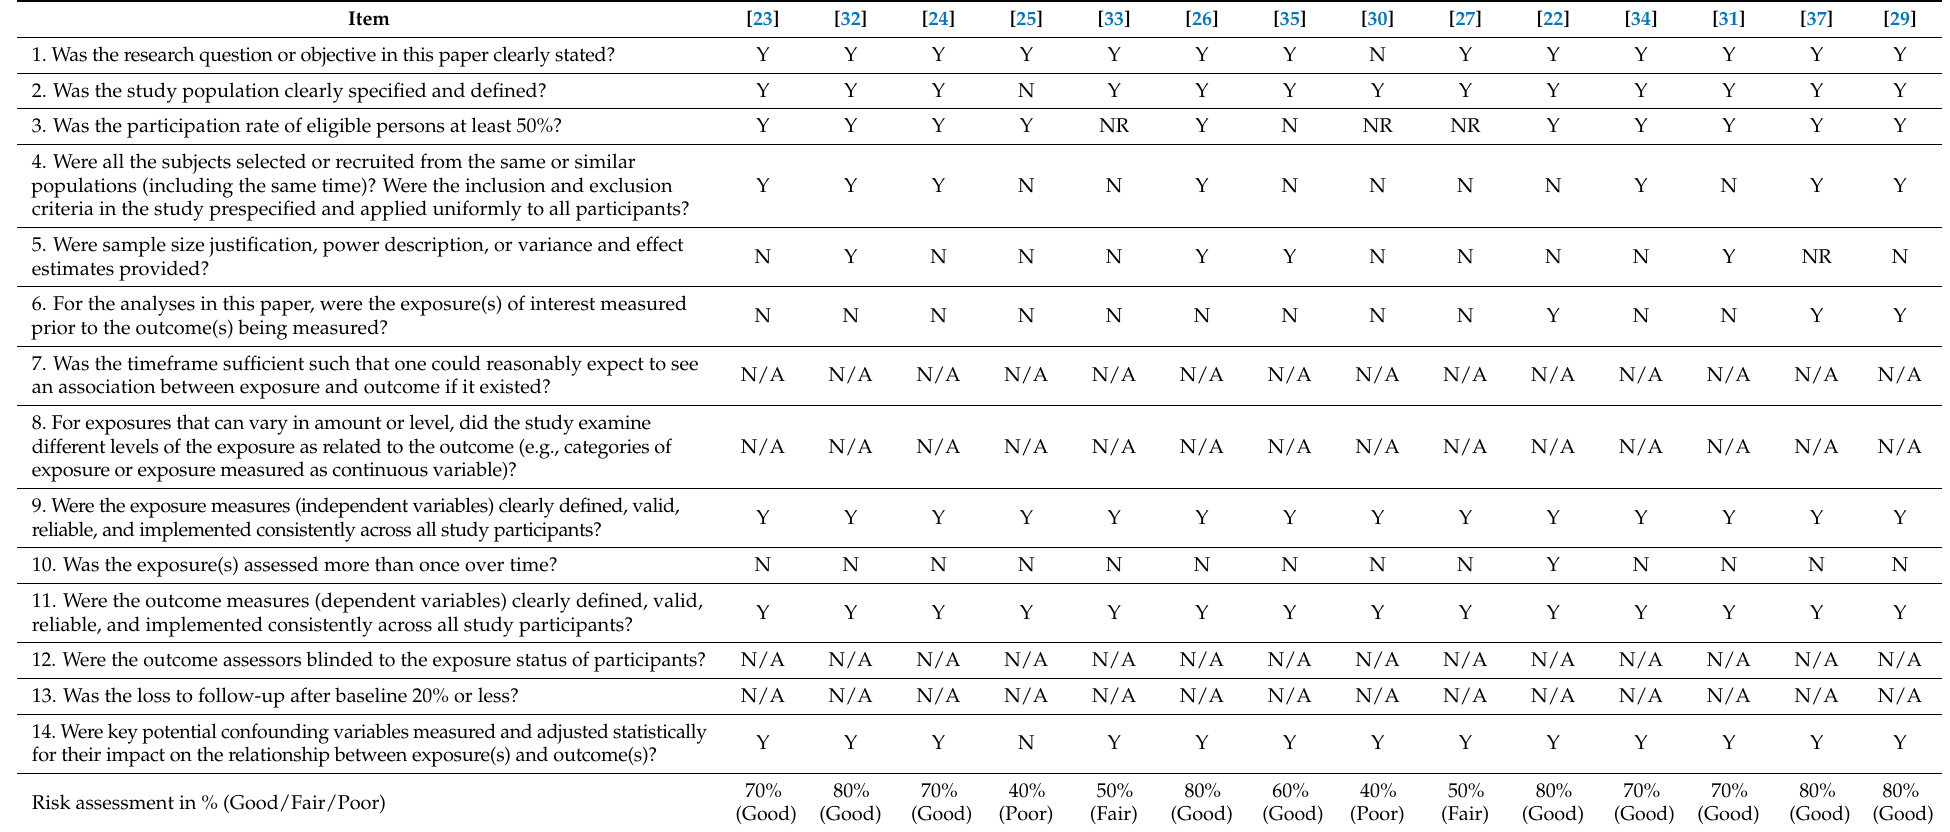
Table A1. NHLBI quality assessment tool used for the observational cohort and cross-sectional